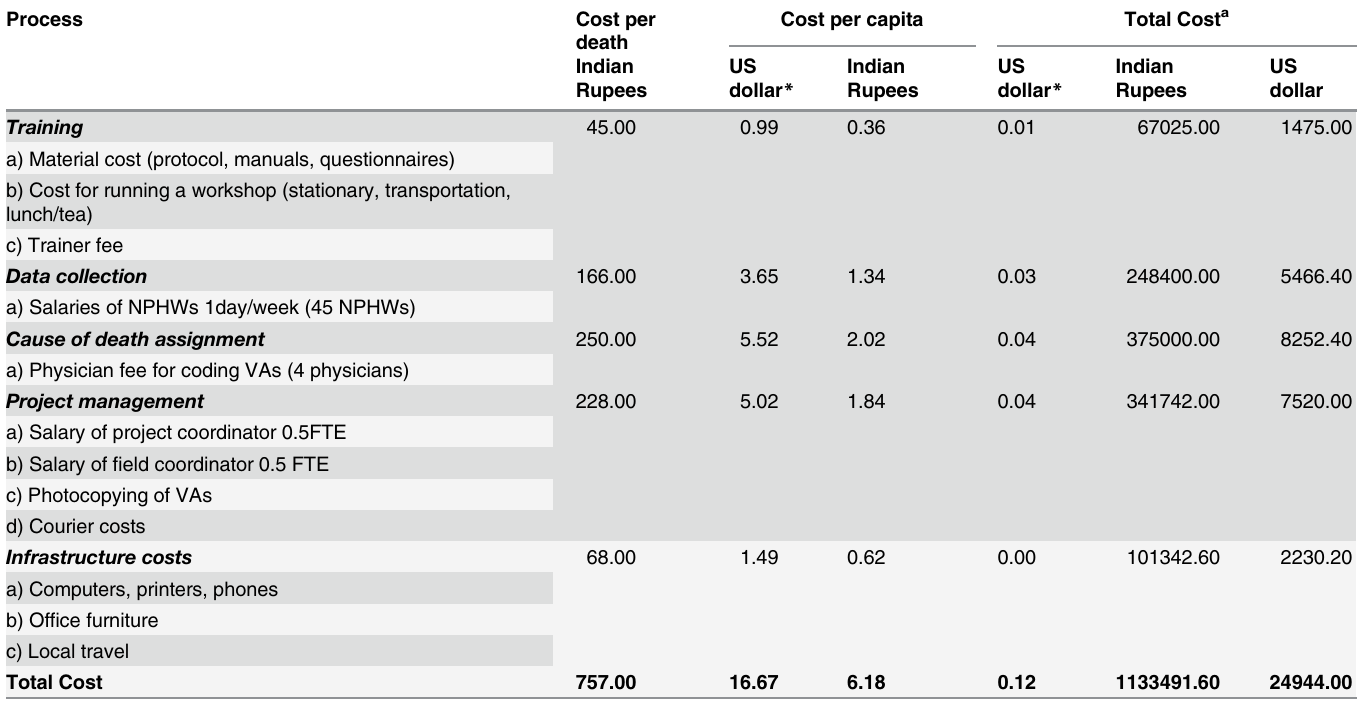
Table 1. Start-up cost of the VA based mortality surveillance (2003 –